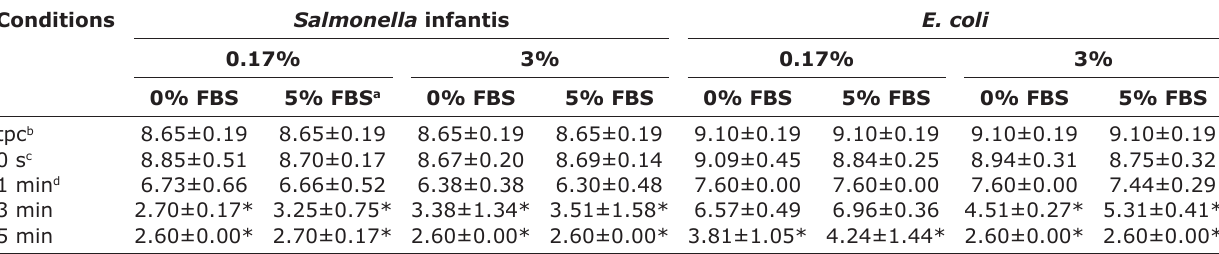
Table-2: The results are presented as log CFU/ml (mean±SE) of Salmonella infantis and E. coli inactivating efficacy, 10 using 0.17% and 3% of food additive grade calcium hydroxide solution, in the absence or presence of organic materials.